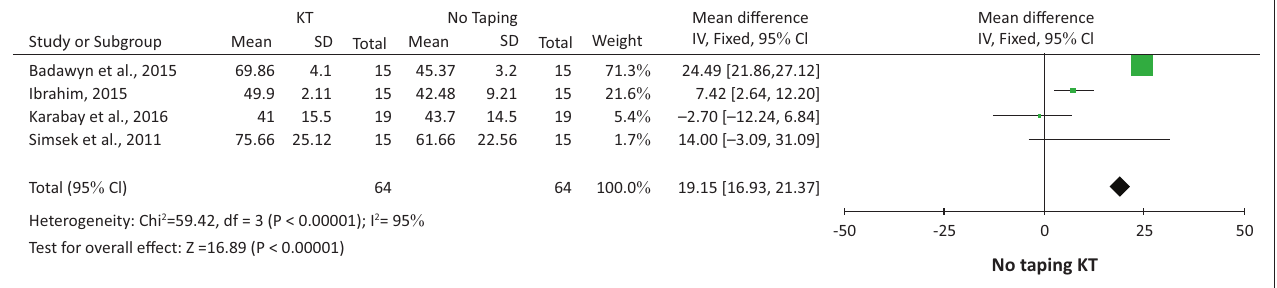
FIGURE 1: Kinesiology taping versus no taping as measured by Gross Motor Function Measure (B) sitting function at the end of the intervention period.